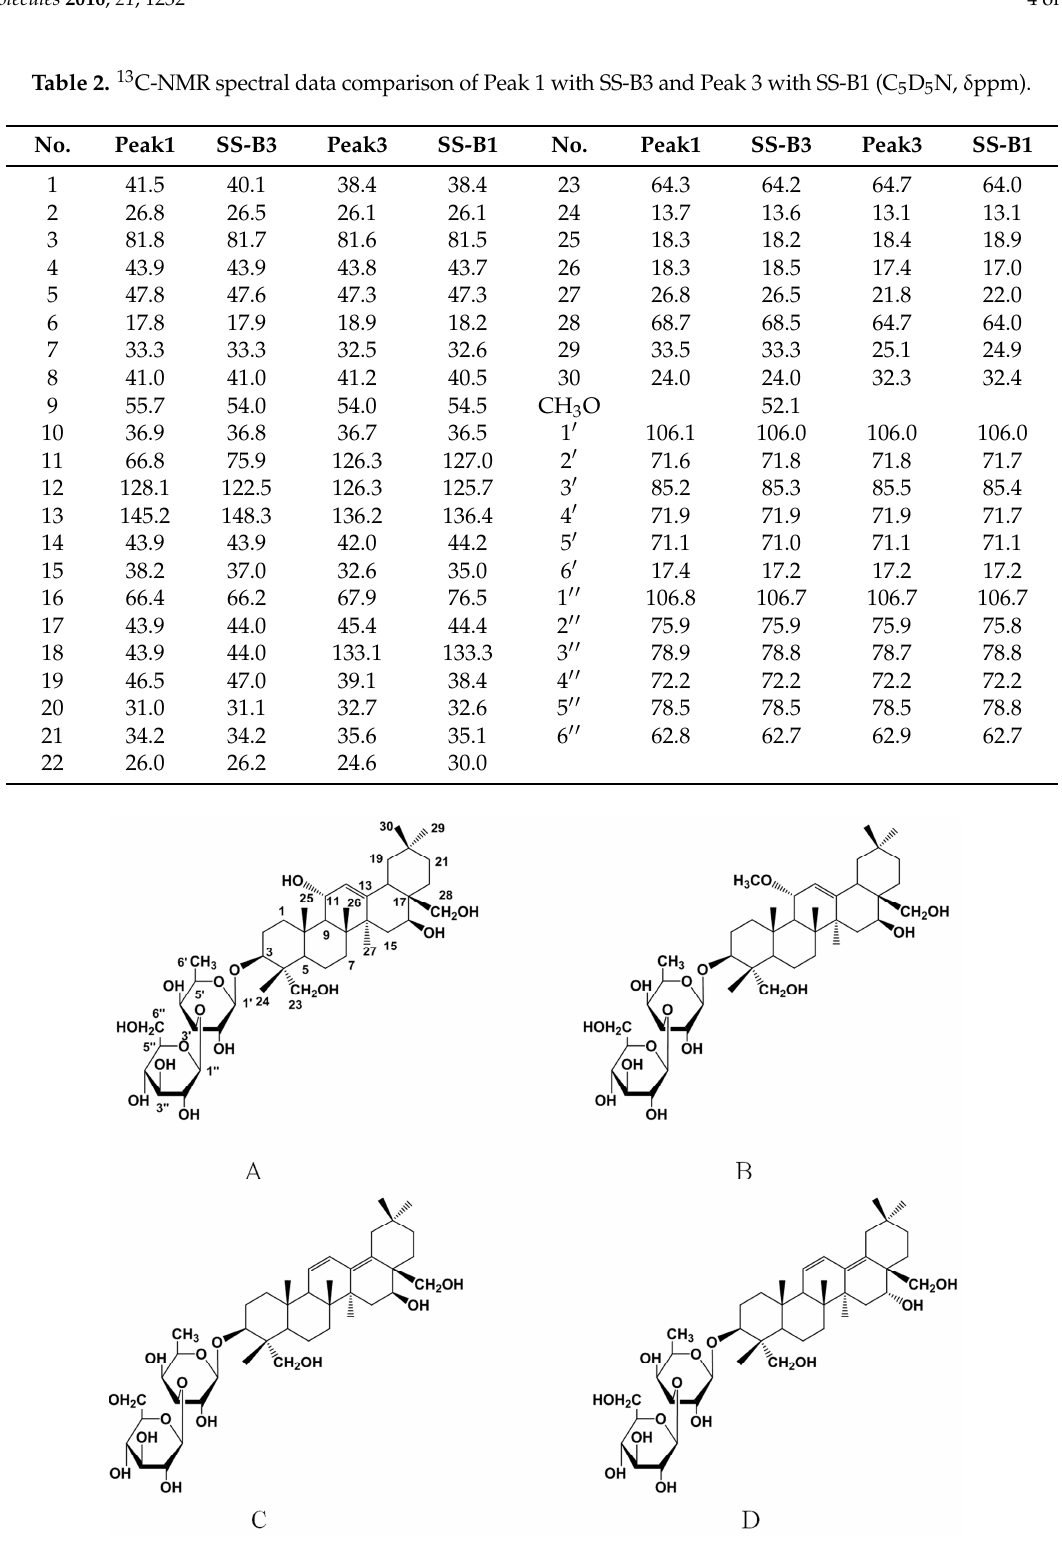
Figure 3. Structural formulas of hydroxy-saikosaponin A ( A ); SS-B3 ( B ); SS-B1 ( C ); and SS-B2 ( D ).